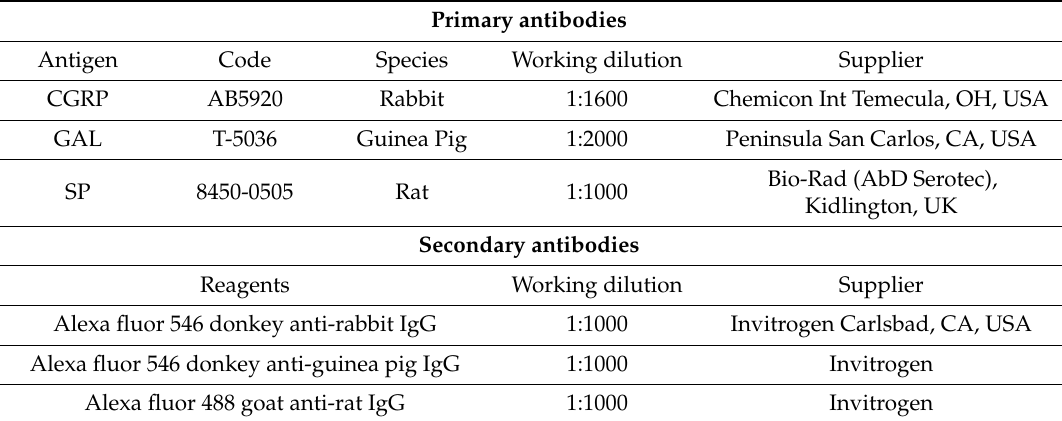
Table 1. List of antisera and reagents used in immunohistochemical